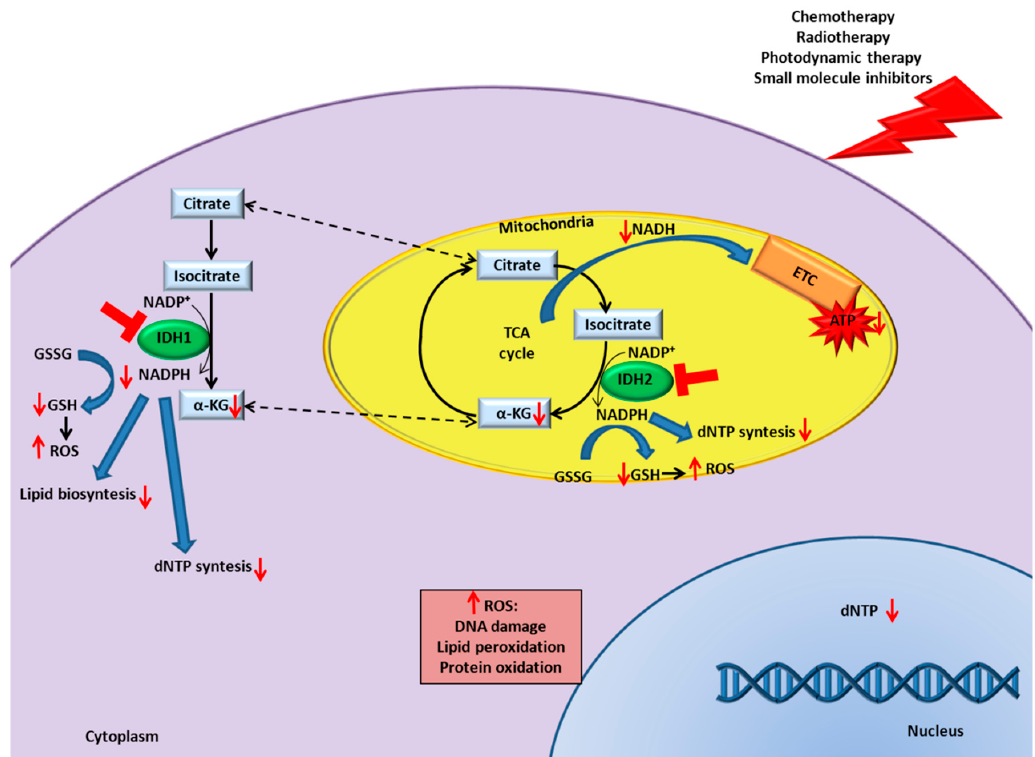
Figure 1. IDH inhibition enhances canonical cancer therapies e ffi cacy. Schematic representation of the underlying mechanisms that increase the response to cancer therapies in presence of IDH1 / 2